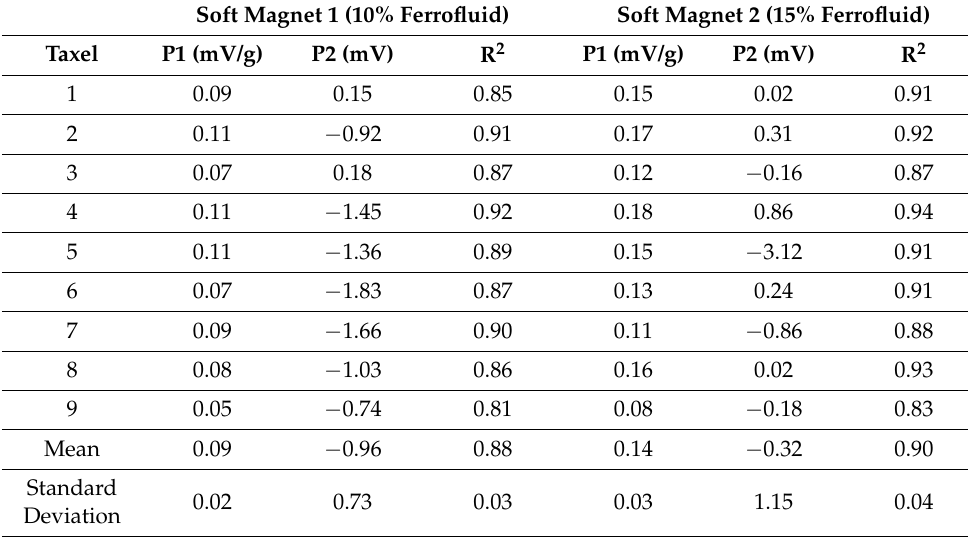
Table 2. Linear fit model parameters for both soft magnets. The linear model polynomials have a form: Hall effect sensor (mV) = P1* (Load (g)) +